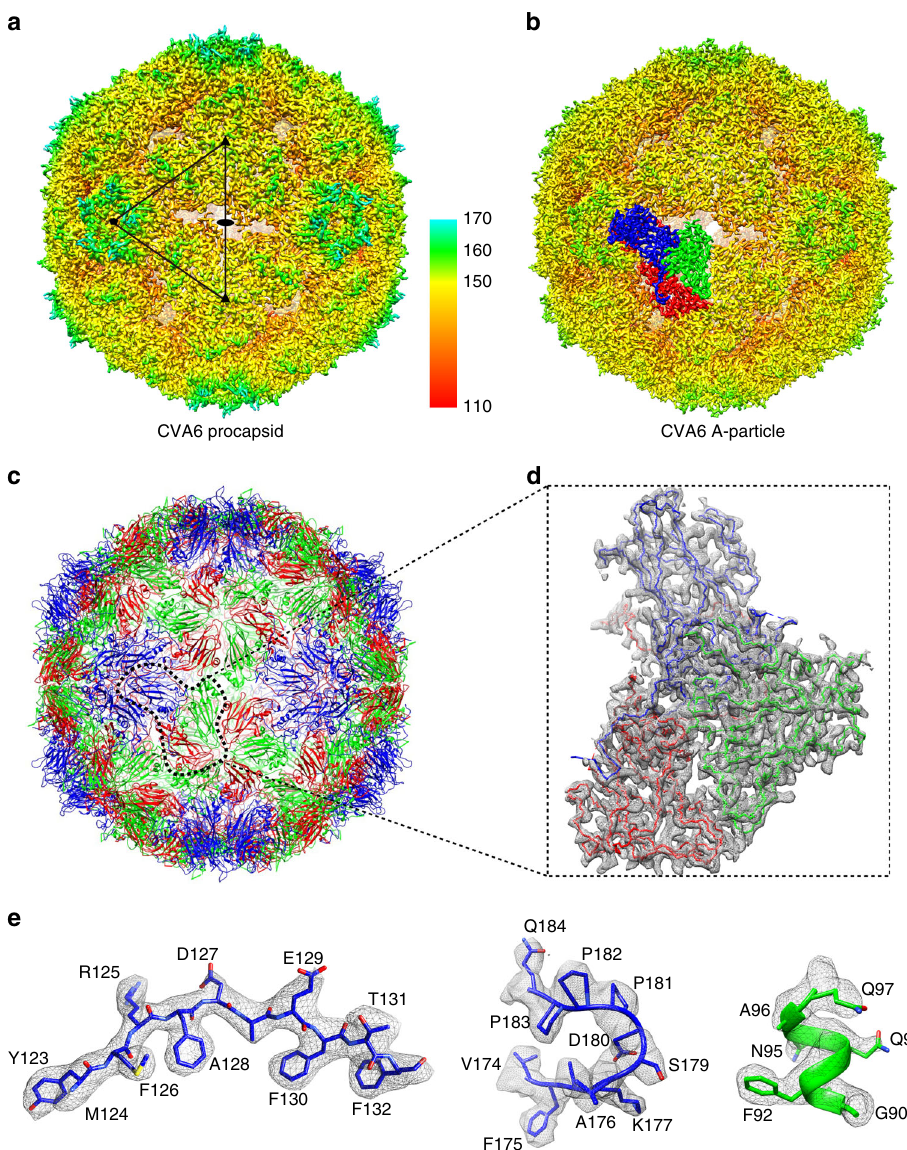
Fig. 2 CryoEM structures of CVA6 procapsid and A-particle. a , b Iso-contoured views (radially colored) of cryoEM density maps of procapsid a and A-particle b viewed along a 2-fold axis. One icosahedral asymmetric unit is marked with a black triangle in a and a single icosahedral protomer is drawn in b , c . The maps of the procapsid and A-particle are essentially identical. c Atomic model of the A-particle capsid. The ribbon diagram demonstrates the pseudo T = 3 arrangement of component proteins: VP1 ( blue ), VP2 ( green ) and VP3 ( red ). This color scheme is used throughout the manuscript unless noted otherwise. d One segmented asymmetric unit of the A-particle density map ( gray ) fi tted with its atomic model (C α backbones) to highlight the densities attributed to each individual protein. e The quality of the A-particle density map ( gray ) is illustrated by the fi t of backbone and side chains for three separate structural motifs: a β -strand (VP1), a loop (VP1) and an α -helix